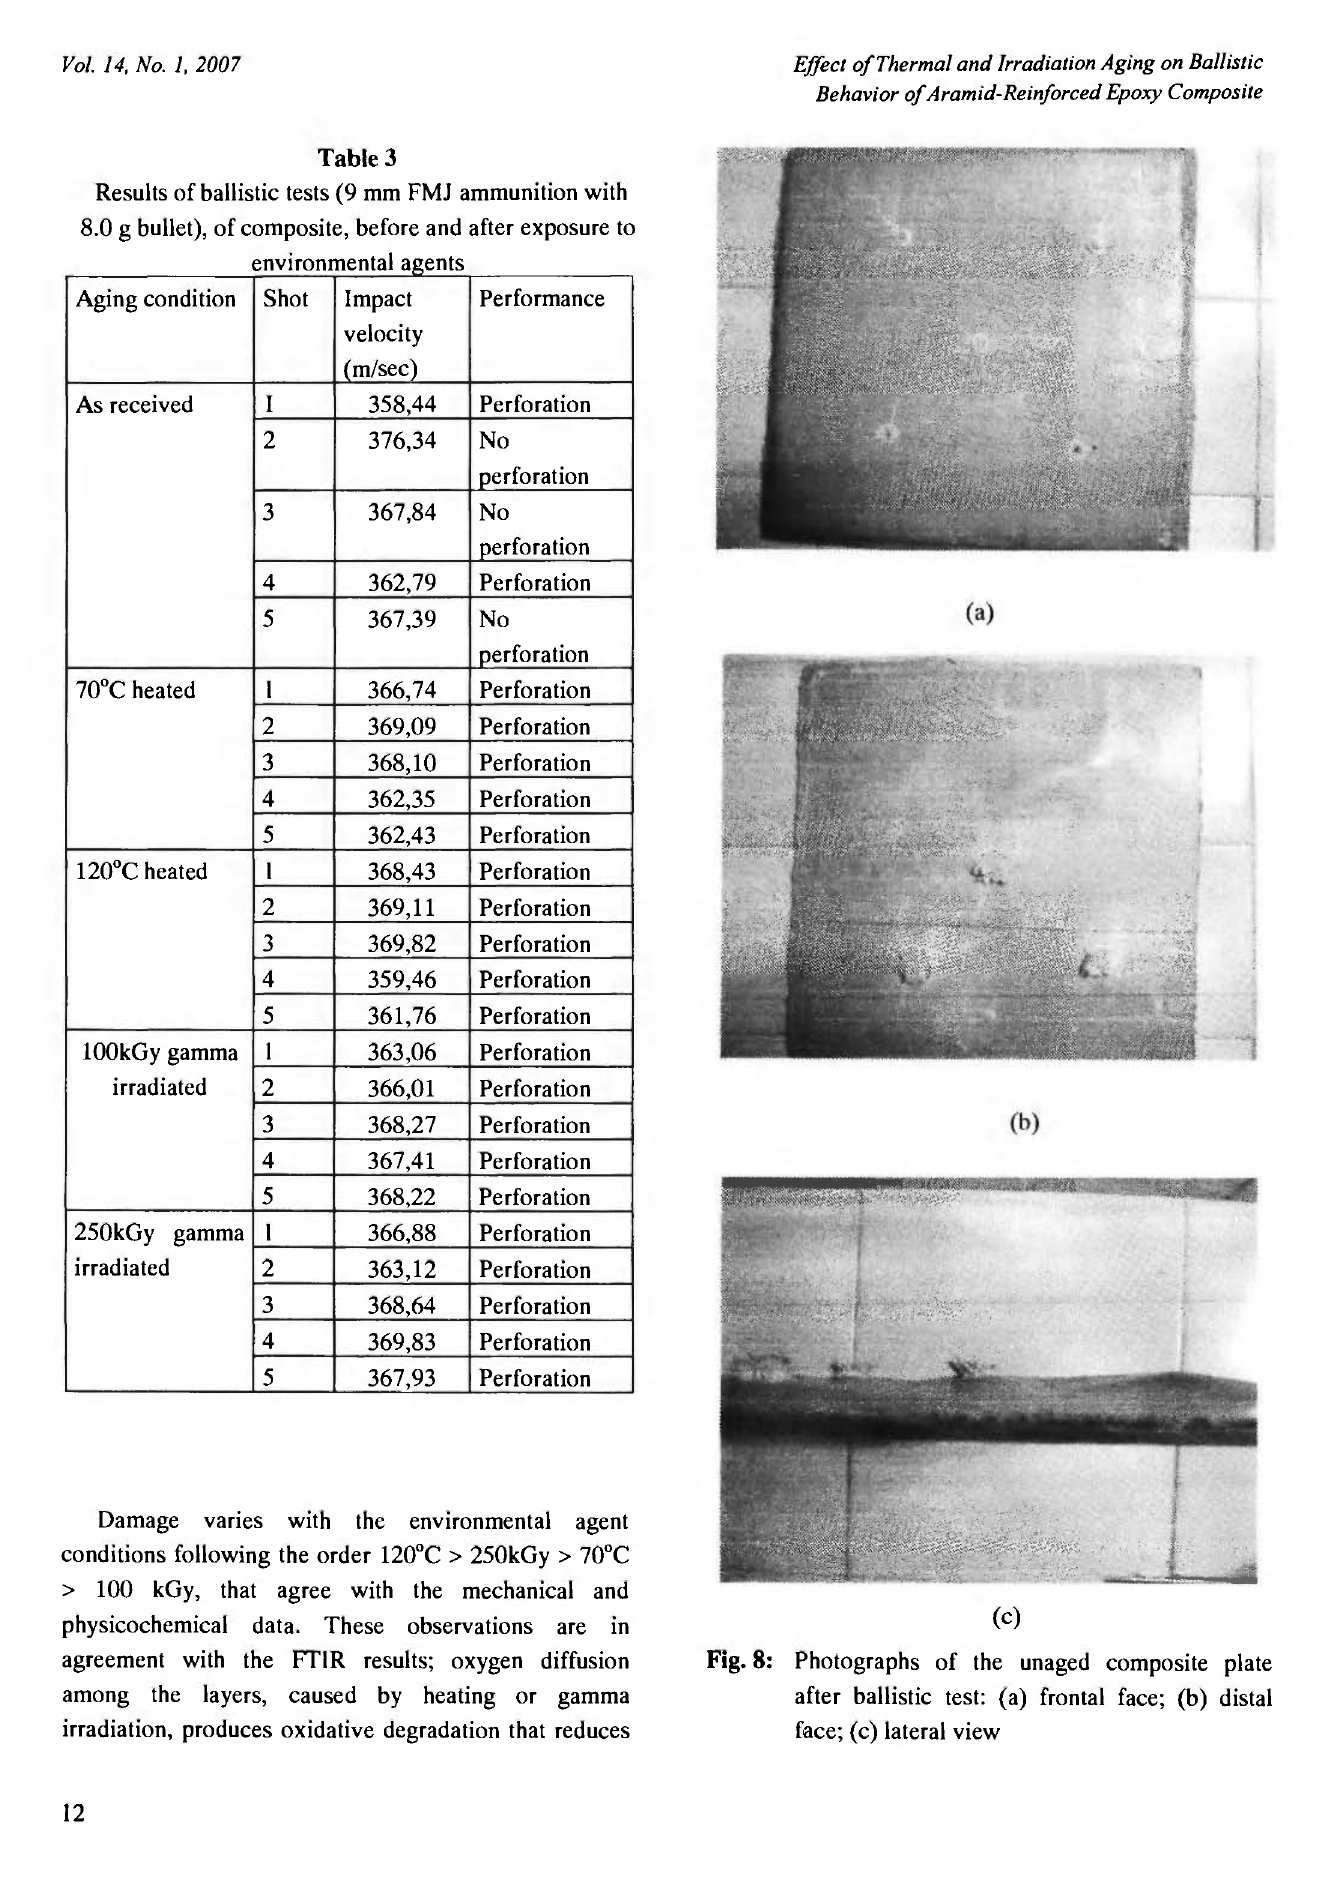
Fig. 8: Photographs of the unaged composite plate after ballistic test: (a) frontal face; (b) distal face; (c) lateral